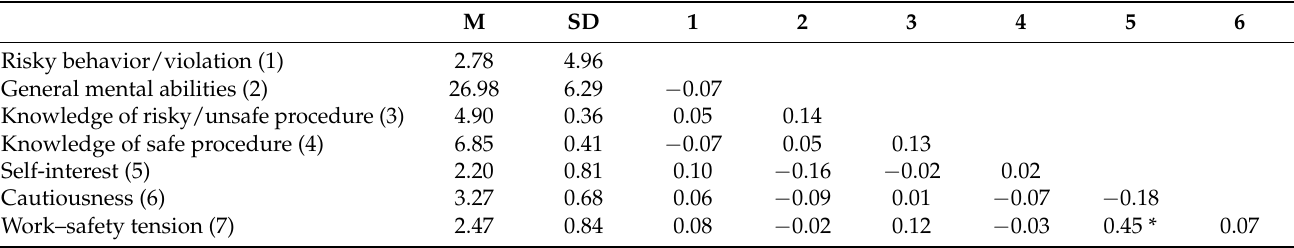
Table 3. Correlation table of control and dependent variables.